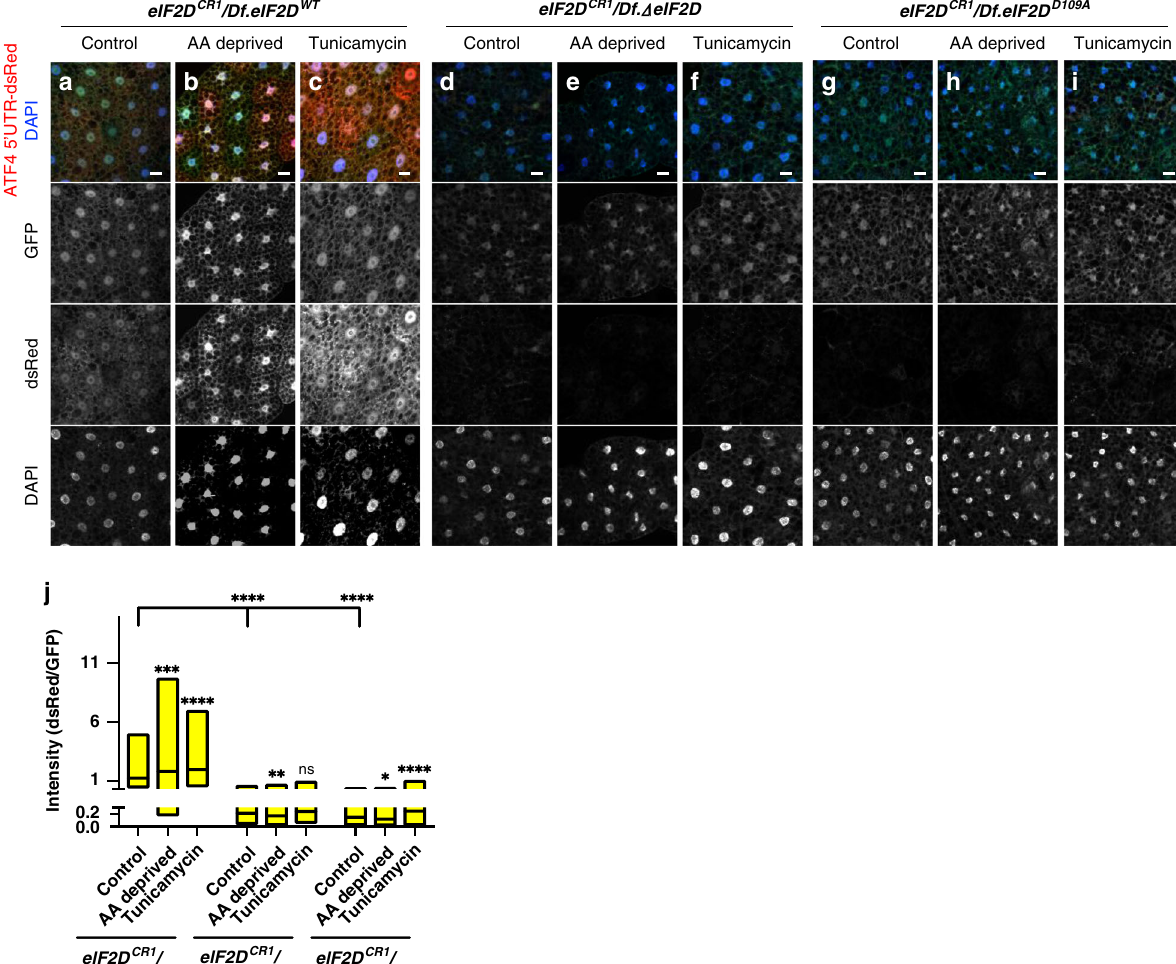
Methods Drosophila genetics . All Drosophila lines generated and used in this study are listed in Supplementary Table 1. Flies were reared under standard conditions. Oligos are listed in Supplementary Table 2. For quanti fi cation of fl uorescent images and western blots, p -values were calculated using the two-tailed T -test for two independent means. For retinal degeneration assays, p values were calculated through Log-rank analysis using the Mantel-Cox test. eIF2D mutants (Df(3R)eIF2D) . To generate a De fi ciency line deleting the eIF2D locus, we employed the FRT-mediated recombination strategy using two insertion plasmid (CH321-74G8) as template. For the eIF2D D109A rescue transgene, the WT rescue plasmid was cut with unique sites Bsu36I and StuI and replaced with a corresponding D109A mutation-bearing DNA fragment generated by gene synthesis. The rescue fragments were cloned into the EcoR1 site in p-attB by InFusion assembly (ClonTech) and injected into embryos for targeted insertion into the attP2 locus. The resulting transgenes were recombined with the Df(3R) eIF2D lines to generate Df.eIF2D WT wild type and the Df. Δ eIF2D mutant lines. To generate eIF2D CR1 , we used CRISPR-Cas9 to introduce a single cut in the fi rst exon